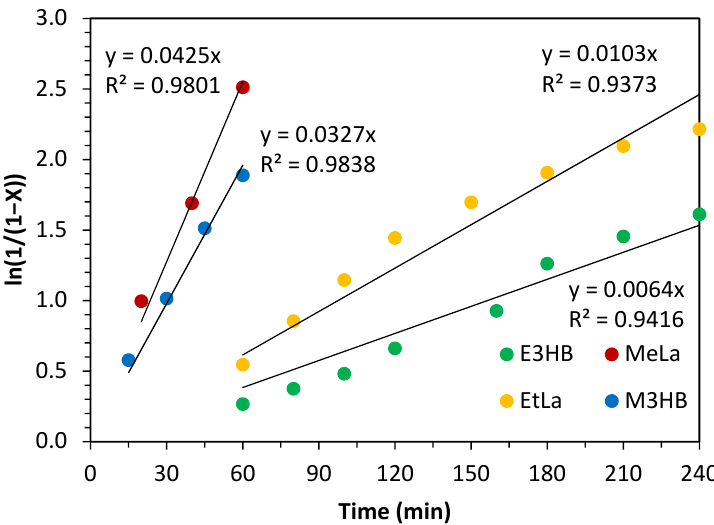
Figure 3. Kinetics of depolymerization of PLA and PHB polymers providing reaction rate constants ( k ). Table 2. The values of reaction rate constants ( k ) for depolymerization of PLA and PHB via alcoholysis. Methyl Ethyl Methyl Lactate Lactate